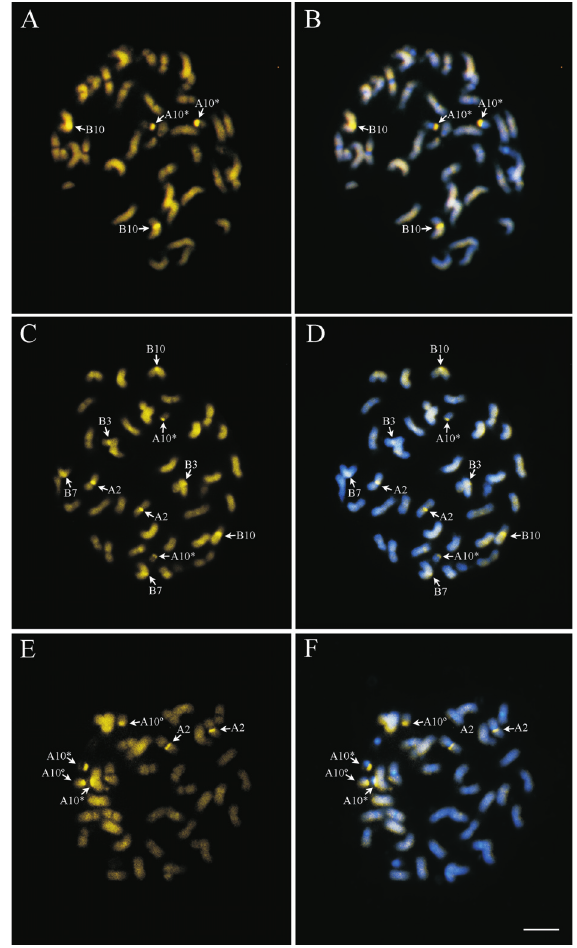
Figure3 -ChromosomesshowingCMA 3+ bands(arrows)ontheproximal region of the chromosomes (A, C, E). Overlap of CMA 3 (yellow) and DAPI (blue) (B, D, F). A, B Xingu type Of 126, representing the similar resultsofallthreeXinguaccessions; C,D A.hypogaea ‘IACTatu-ST’and E, F) A. monticola V 14165. A10: short arm and proximal segments of the long arm (*) and satellite (°). Bar: 5 (cid:2)